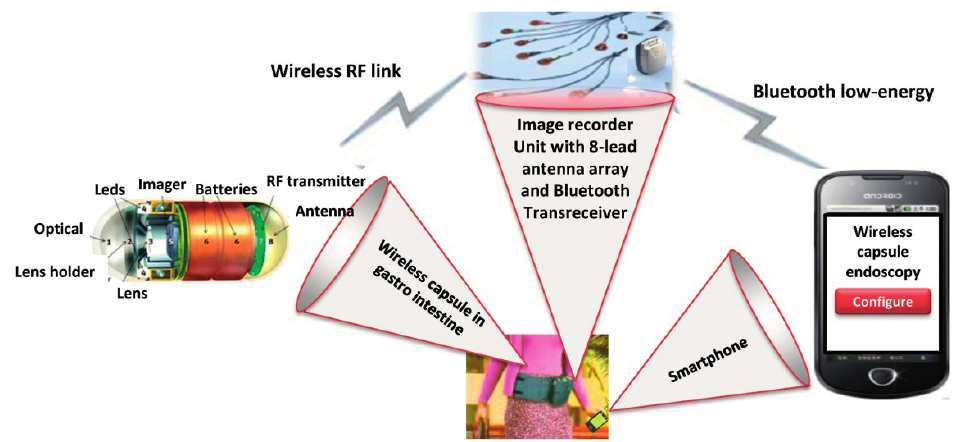
Figure 2. Smartphone data logger for wireless